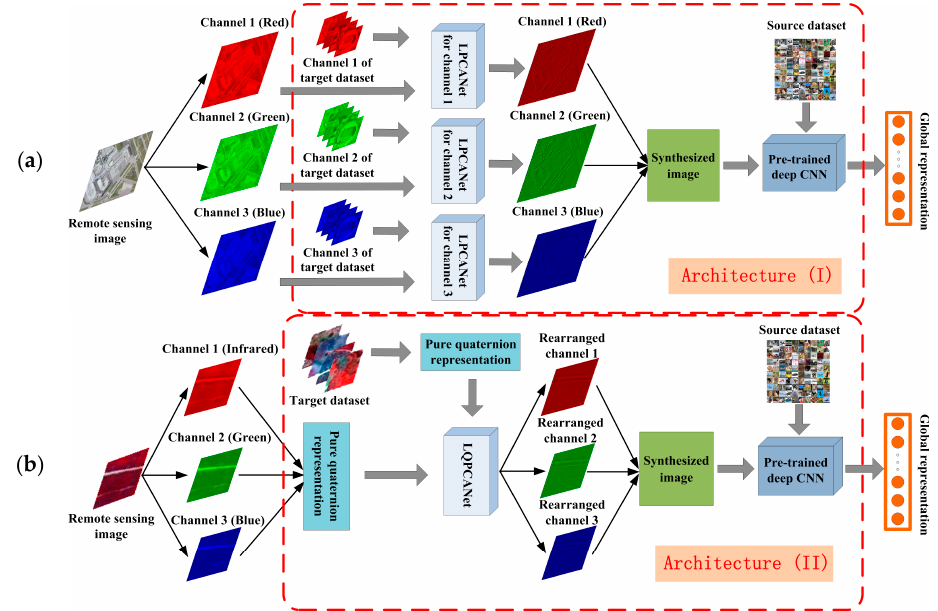
Figure 7. Illustration of the two proposed architectures to enhance the generalization power of pre-trained deep CNNs for remote scene classification. In ( a ) Architecture (I), we use linear PCA networkto synthesize the spatial information of remote sensing imagery in each spectral channel. In ( b ) Architecture (II), after represent the remote sensing imagery as pure quaternion, we use linear quaternion PCA network to further synthesize the spectral information of them.